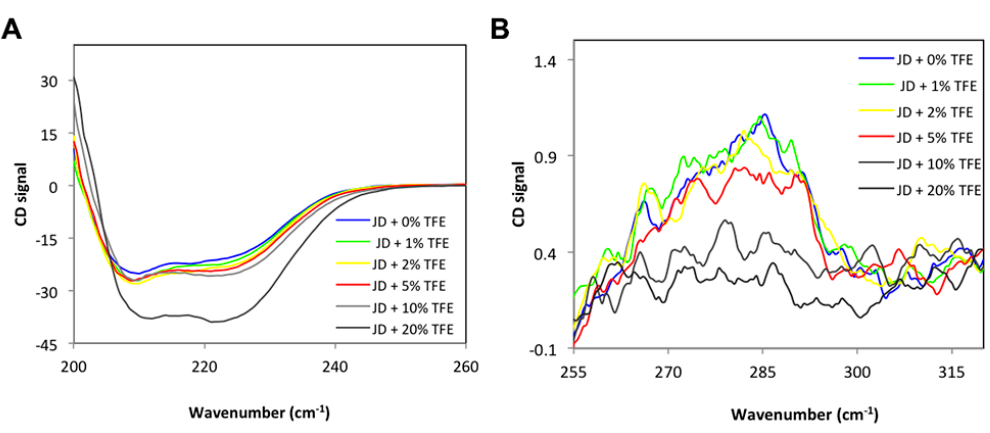
Figure 2. CD spectra of JD at different TFE concentrations ( v / v ). ( A ) Far UV CD spectra; ( B ) near UV CD spectra. All measurements were performed at 25 °C.